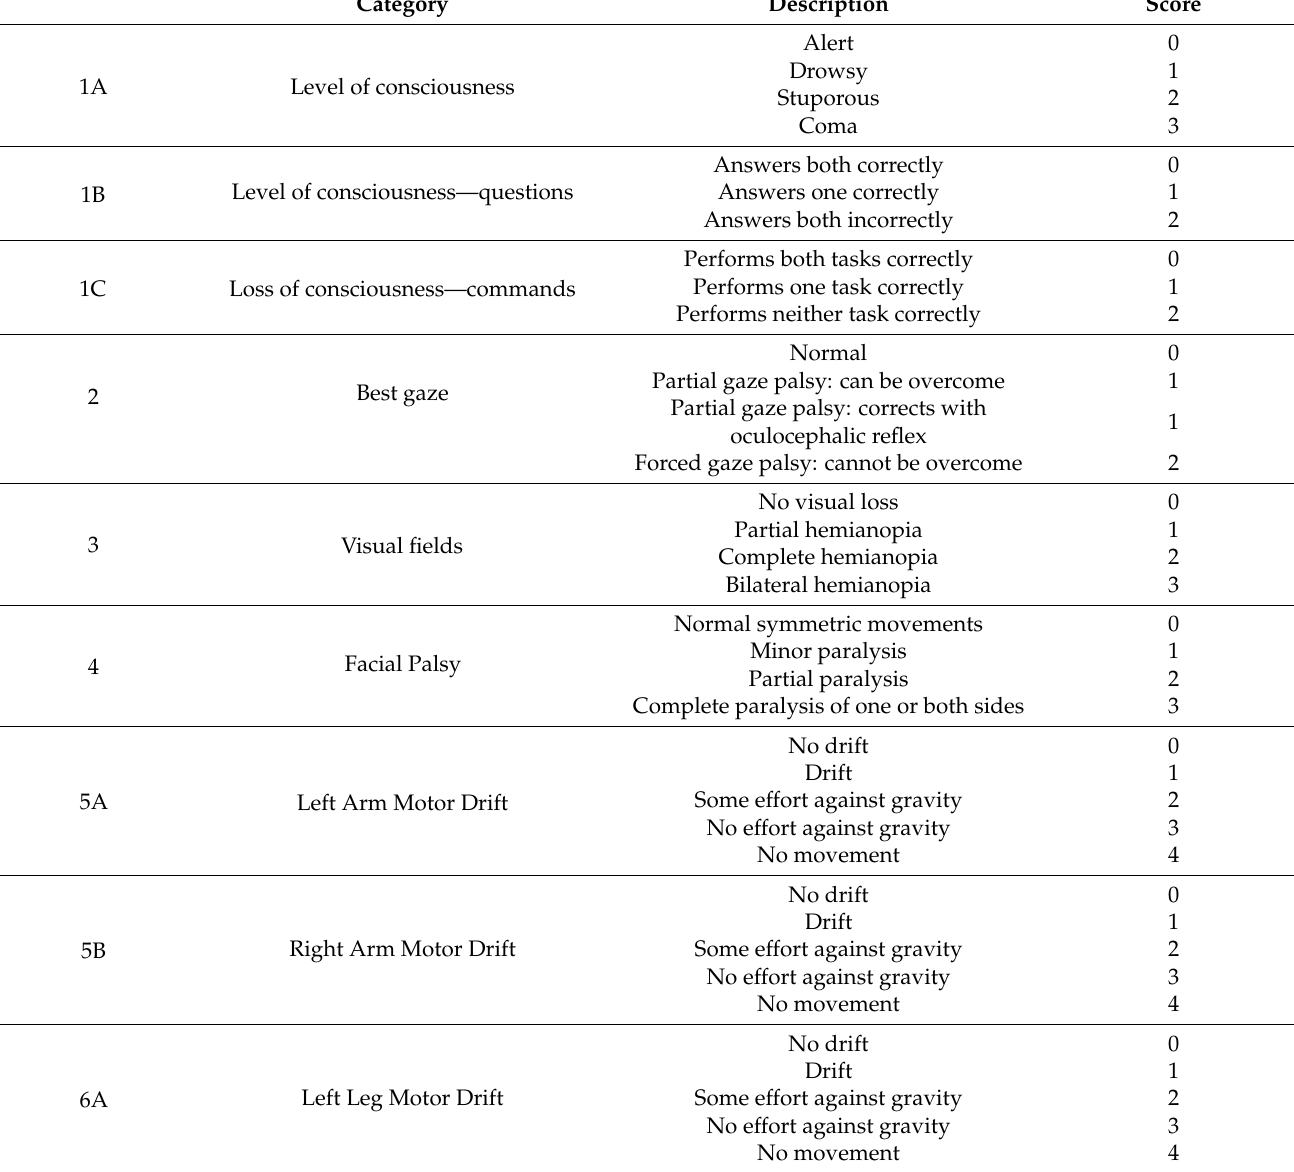
Table 1. National Institutes of Health Stroke